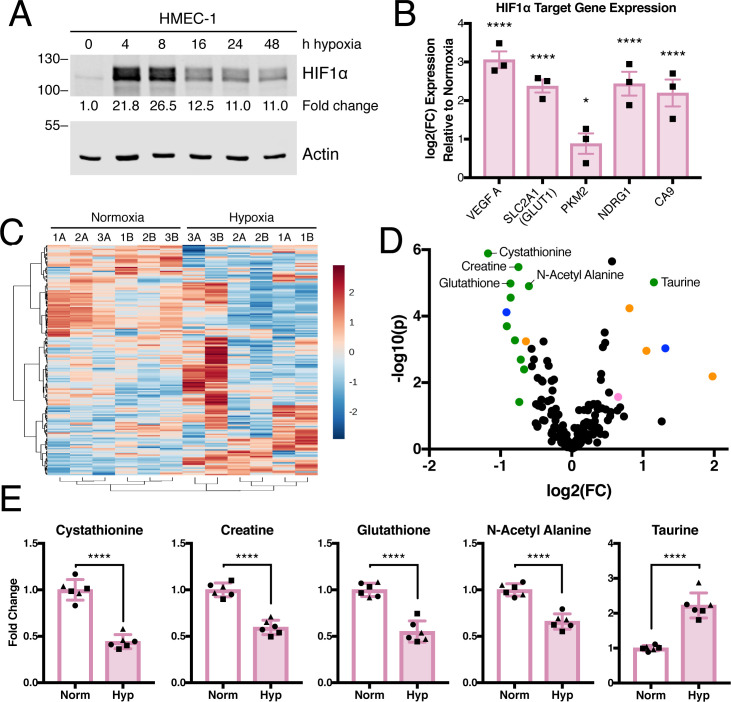
Hypoxia alters the metabolite profile of microvascular cells.(A) Lysates were prepared from HMEC-1 cells exposed to a time course of hypoxia and immunoblotted for HIF1α expression. Relative HIF1α expression was calculated using LI-COR Image Studio and is expressed as fold change relative to time = 0 sample. Representative of N = 1. (B) mRNA abundance of HIF1α target genes in HMEC-1 cells at 48 hrs of normoxia or hypoxia exposure was measured by quantitative real-time polymerase chain reaction (qRT-PCR) and is expressed as log(2) fold change relative to HMEC-1 cells cultured in normoxia, N = 3 biological replicates. Significance by two-way ANOVA. (C) Fold change metabolite abundance over normoxia control for 178 metabolites detected in all samples as measured by LC-MS/MS in HMEC-1 cells grown in hypoxia for 48 hrs. Number indicates biological replicate, letter represents technical replicate. (D) Effect size and significance by t-test of metabolite changes measured in C. Colored circles indicate p < 0.05 and fold change > 1.5. Top five most significant metabolites over 1.5-fold change are labeled. Colors indicate pathways: green, amino acid metabolism; orange, nucleotide metabolism; pink, sugar and energy metabolism; blue, other. (E) Fold change relative to normoxia of top five most significantly altered metabolites with over 1.5-fold change after 48 hrs in hypoxia. Different symbols represent biological replicates. Significance by unpaired t-test. All error bars represent SEM. *, p < 0.05; ****, p < 0.0001.